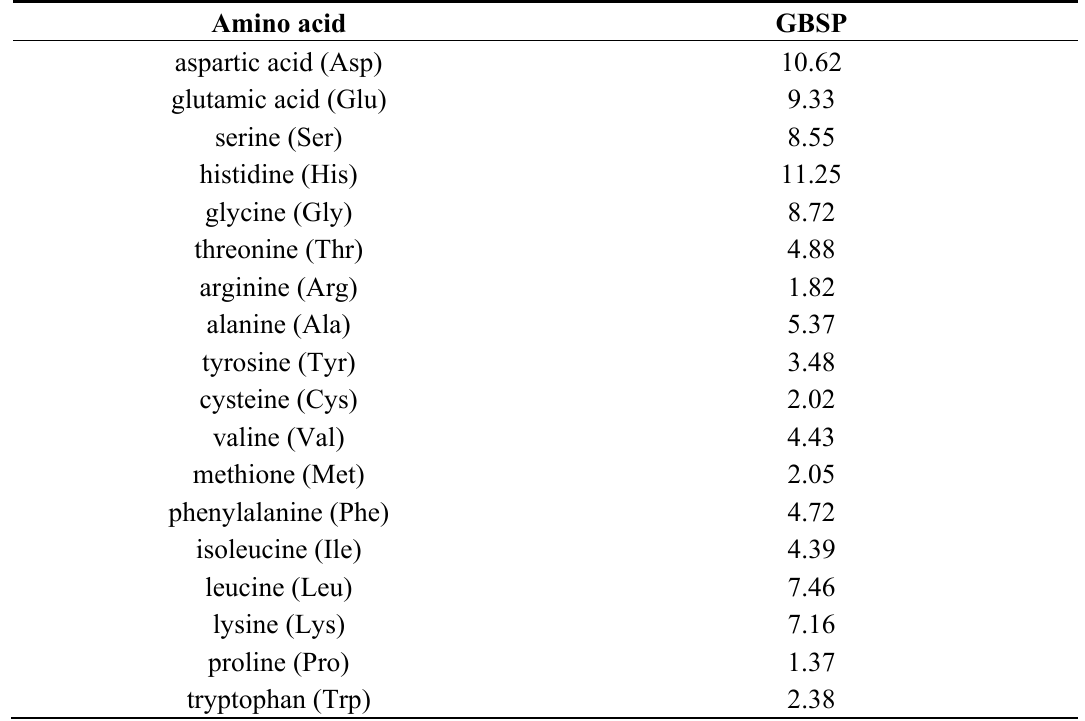
Table 2. Amino acid composition of purified protein (GBSP) powder (g/100 g protein).